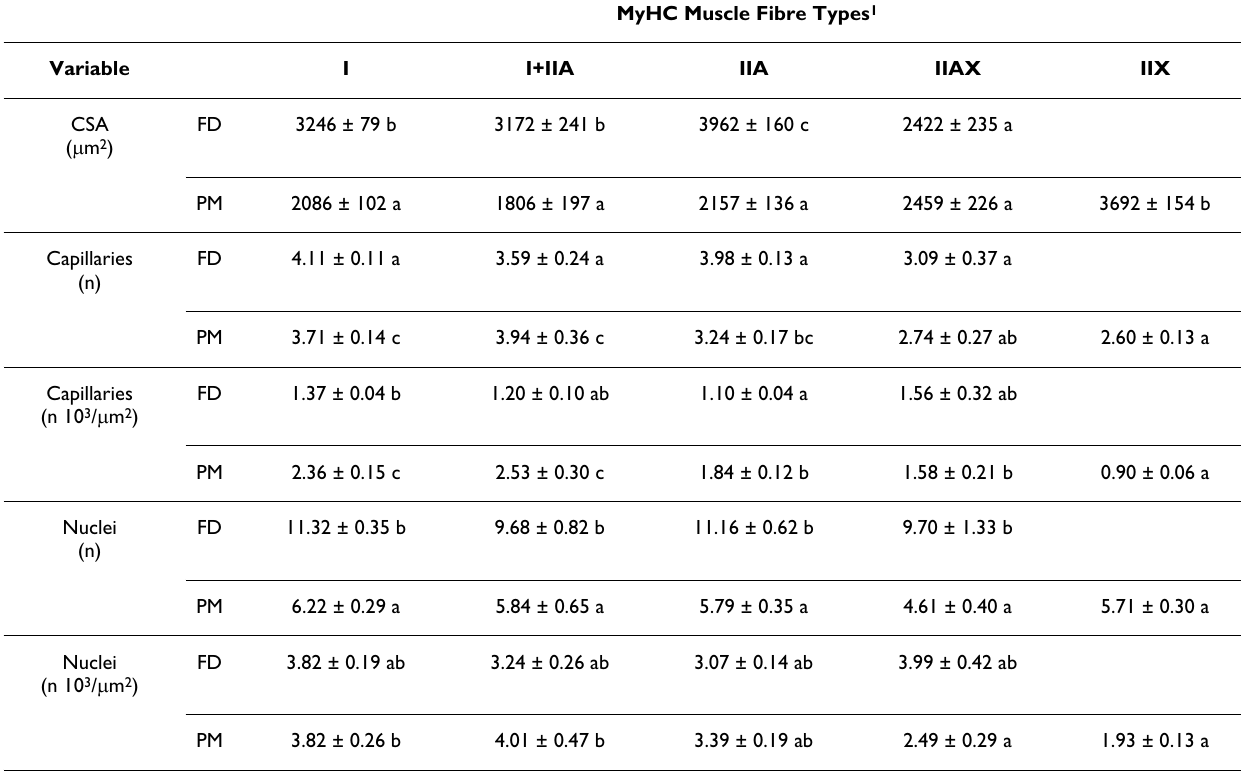
1 See Table 2 for the number of fibre types analysed in each skeletal muscle CSA ( μ m 2 ), and absolute (n) and relative (n 10 3 / μ m 2 ) numbers of both capillaries and nuclei of the different fibre types in each of the two studied muscles are shown. Relative values are obtained by dividing the absolute values by the CSA. Post hoc comparisons of means were provided by a Fisher's least significance difference test. Means with different letters are statistically